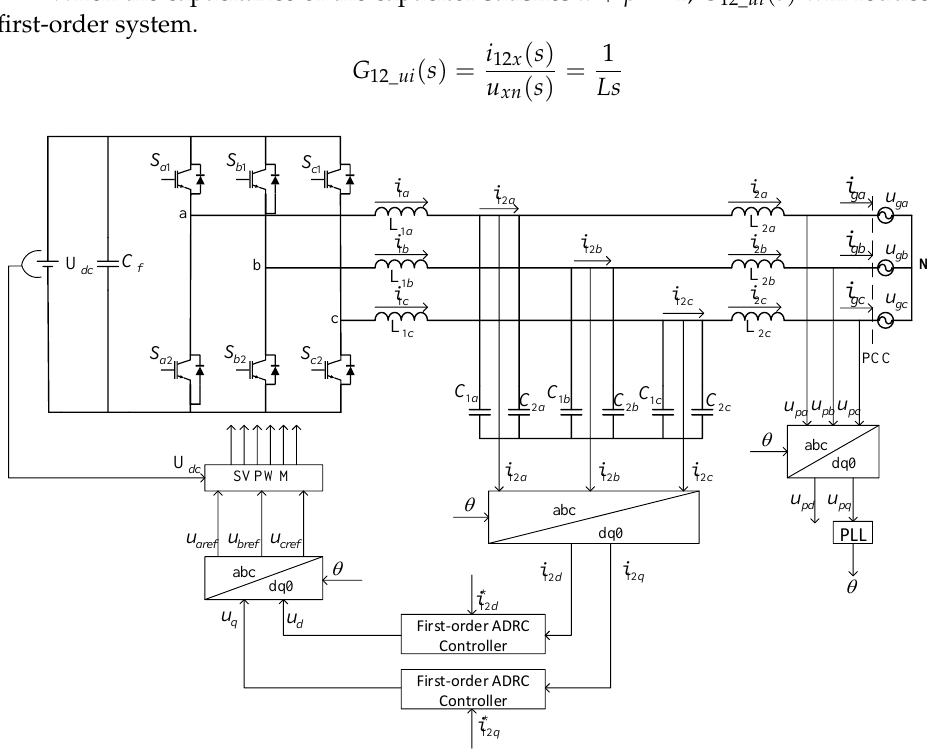
Figure 1. Three-phase LCCL grid-connected inverter.